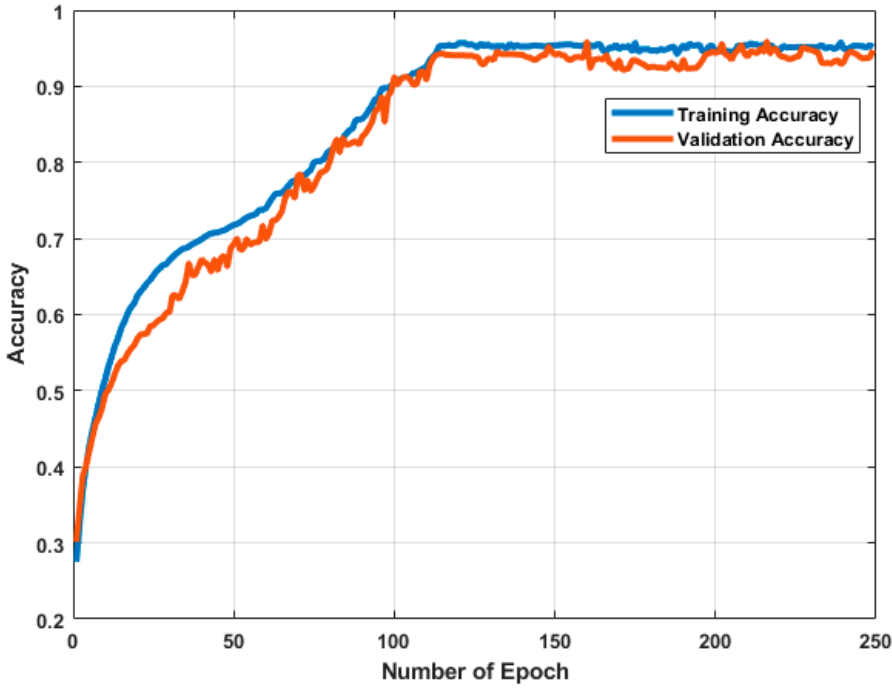
Figure 21. The results for the training and validation data (Accuracy).